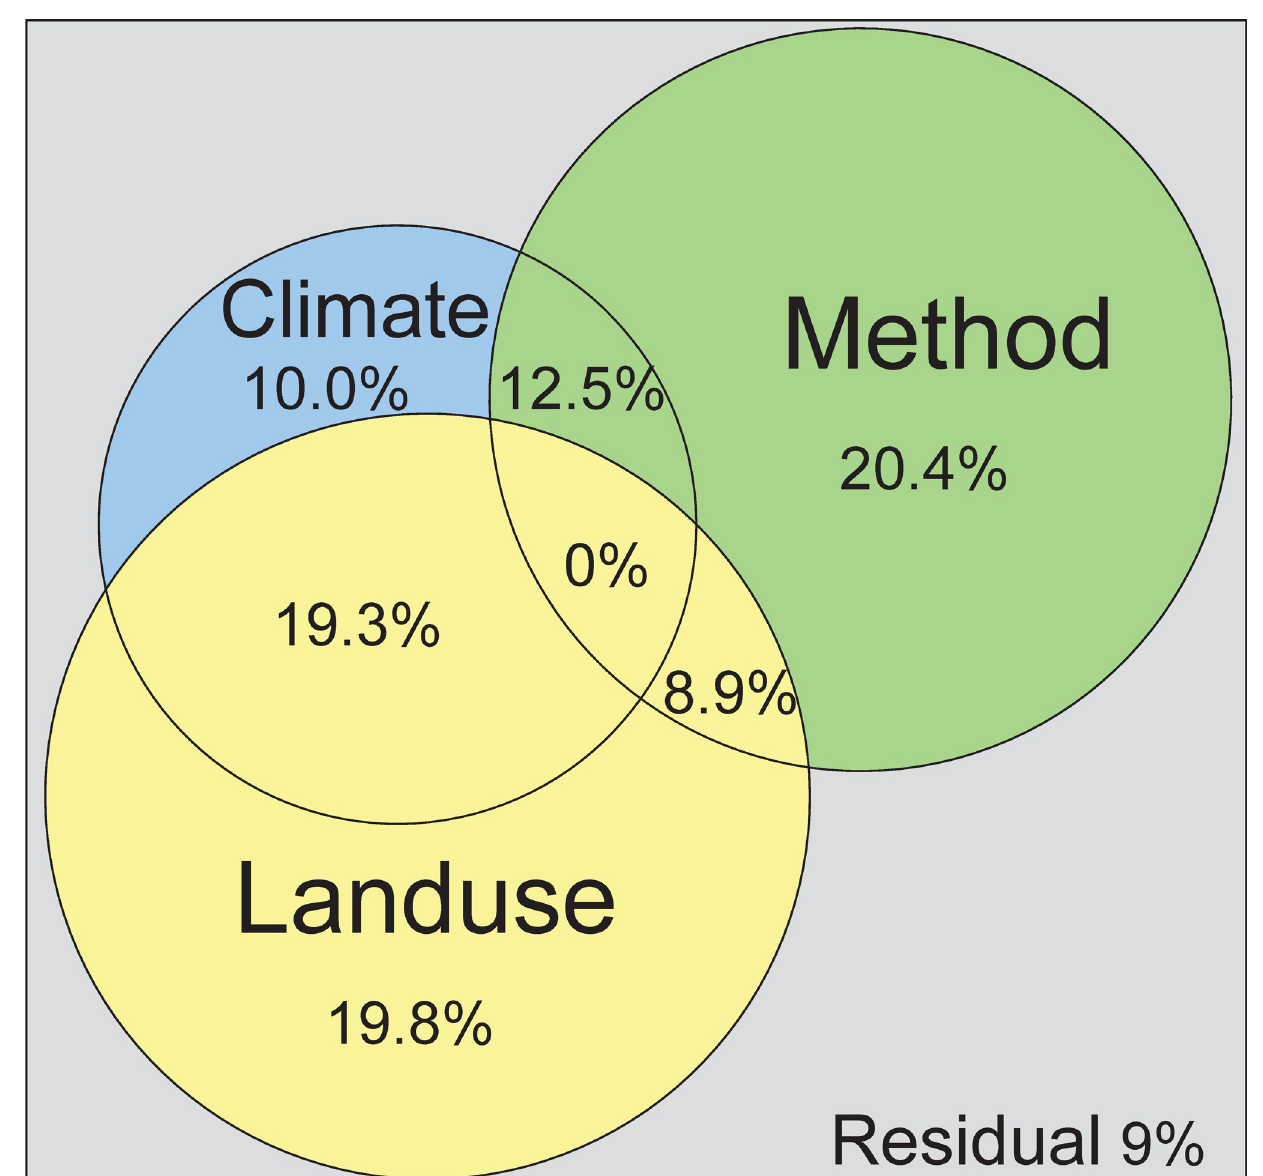
Fig 4. Variation partitioning among the three factor groups of climate, land use, and method. The sizes of the circles roughly represent the relative strength of the effects on the community structure of the longhorn beetles in Kanto. expanded into the Kanto area since the 1980s [41]. We suspect that these temporal trends in the longhorn beetle composition in Ito indicate that the surrounding environment changed from a rural satoyama environment with rich pine woodlots to an urbanised resort area. We also found that P . caudata ( P . cau ), A . fraudator ( A . fra ), M . gracilis ( M . gra1 ), and C . uni- color ( C . uni ) were significantly positively correlated with fall precipitation (Fig 2). Because these species are generally uni-voltine and emerge as adults in the summer, the fall precipita- tion in the last year may influence the survival of their young larvae. Indeed, several studies on other longhorn beetles have reported that fall precipitation positively affects larval survival (e.g. [42, 43]). Although we still do not know why the presence of only these four species